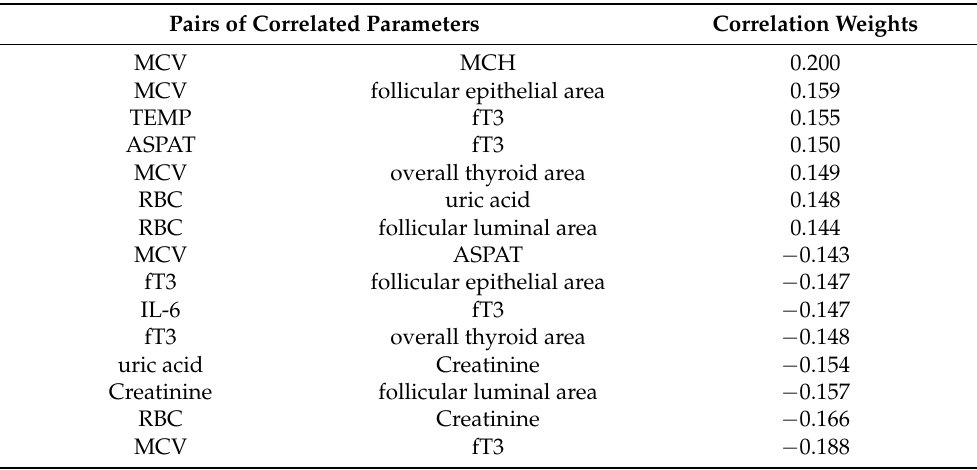
Table 5. Correlation weights for the pairs of parameters based on PLS model (only the first fifteen correlation weights with highest absolute values were shown), see Section 2. for the explanation of all abbreviations.